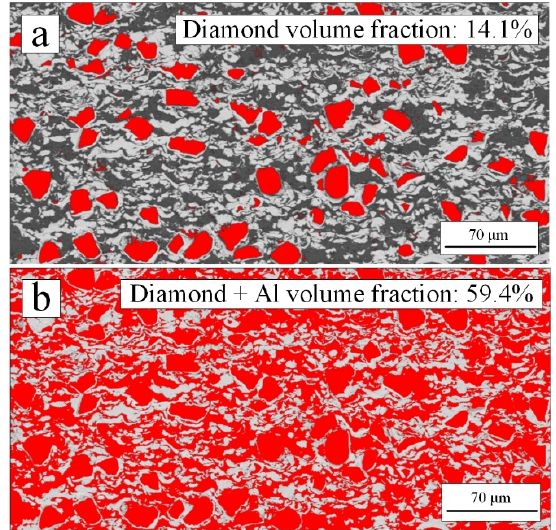
Figure 6. Content of diamond, Ni and Al in the coating analyzed by ImageJ software: ( a ) the diamond was selected by adjusting the threshold of binary image, then the content of diamond was calculated; ( b ) the diamond and Al was selected by adjusting the threshold of binary image, then the content of them was calculated.